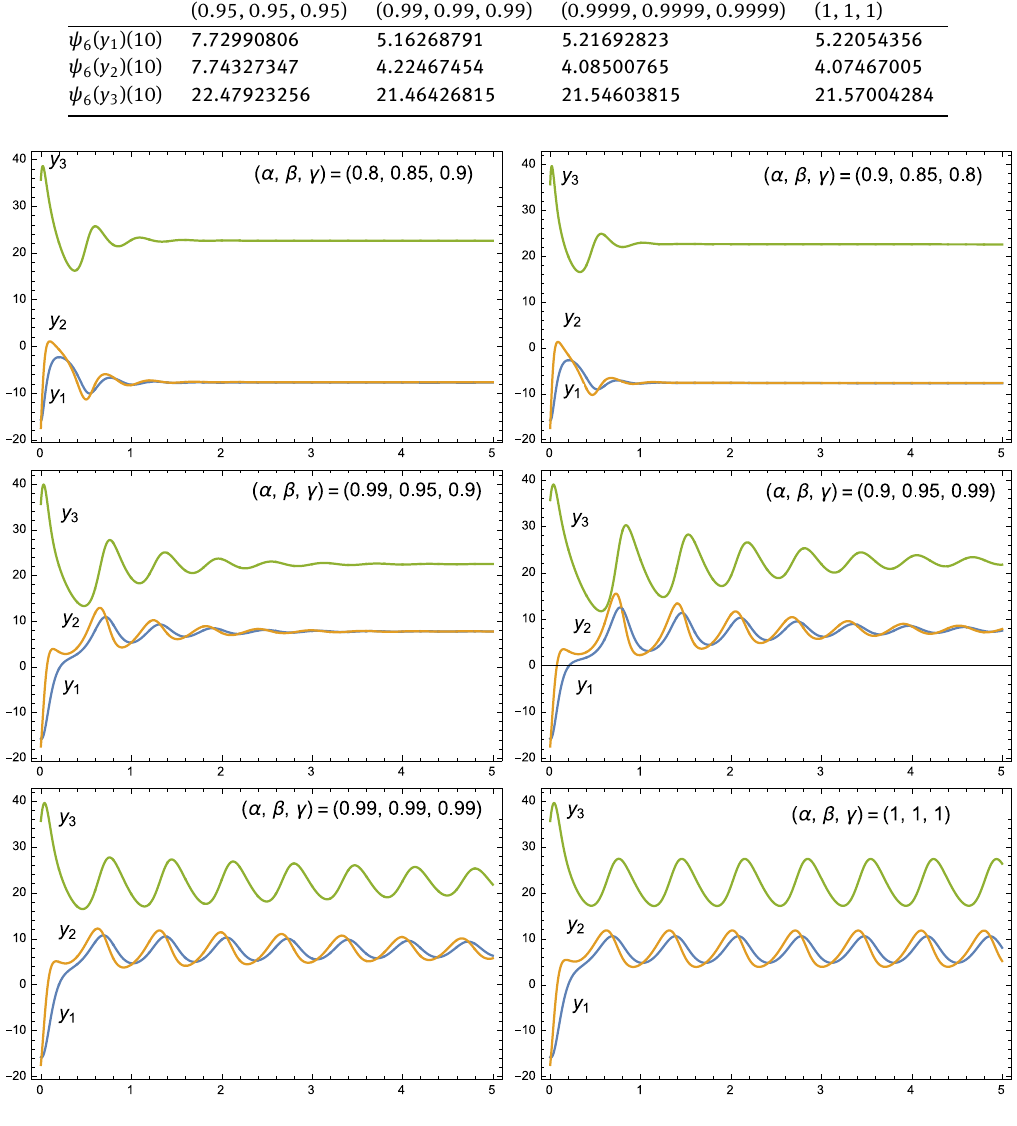
Fig. 13: Computational results for Example 6 with h = 0.1 and N = 10 .